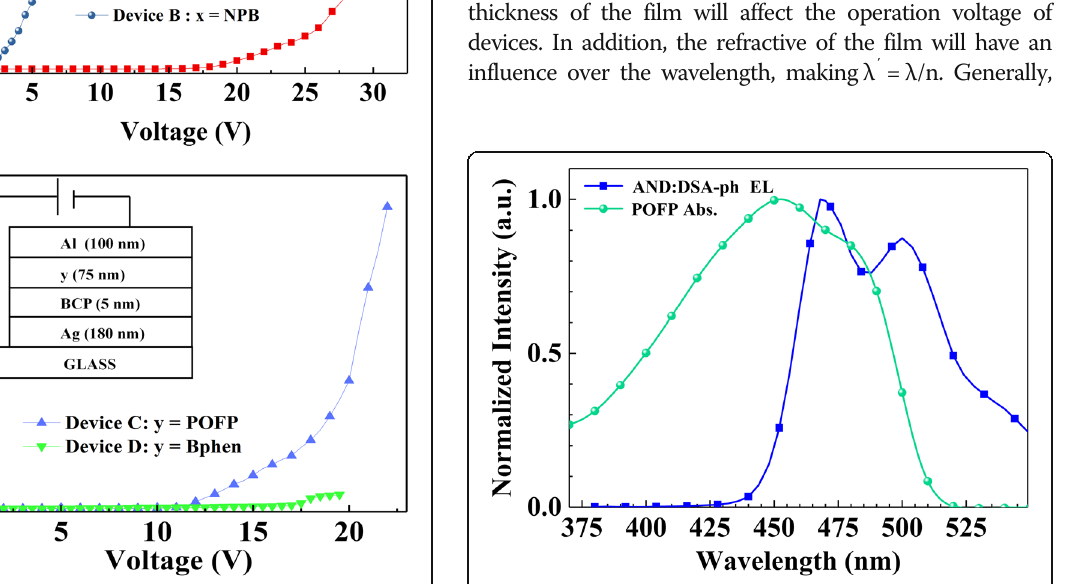
Fig. 3 The J – V characteristics of a hole-only devices and b electron-only devices. The structures of the devices are shown in the insets